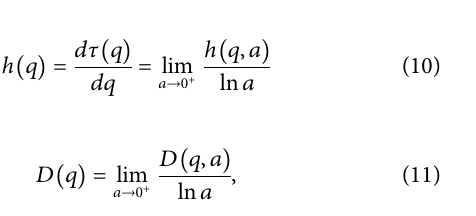
FIGURE 4 | (A) h ( a , q ) curves ( Eq. 8 ) and (B) D ( a , q ) curves ( Eq. 9 ) for q values from − 3 to 5 for fBm surfaces with H = 0.5. (C) h ( q ) ( Eq. 10 ) for fBms with H = 0.1, 0.3, 0.5, 0.7. (D) List of q values used. Corresponding (E) D ( q ) ( Eq. 11 ) and (F) D ( h ).